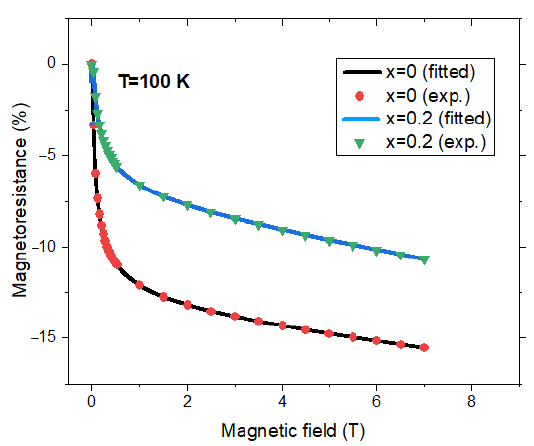
Figure 4. Field dependences of magnetoresistances for Zn x Fe 3 − x O 4 nanocrystalline pellets with x = 0 and 0.2. Experimental data [38] and fitted curves according to relation (4) with parameters listed in Table 2.